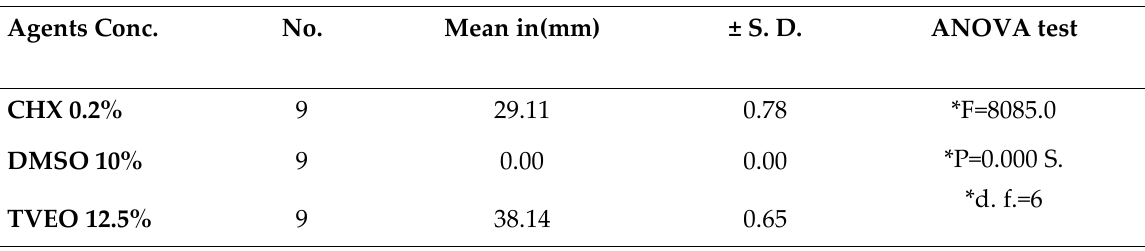
Table 3: The statistical analysis of S.sanguinis inhibition zones by different conc. of TVO, CHX and Agents